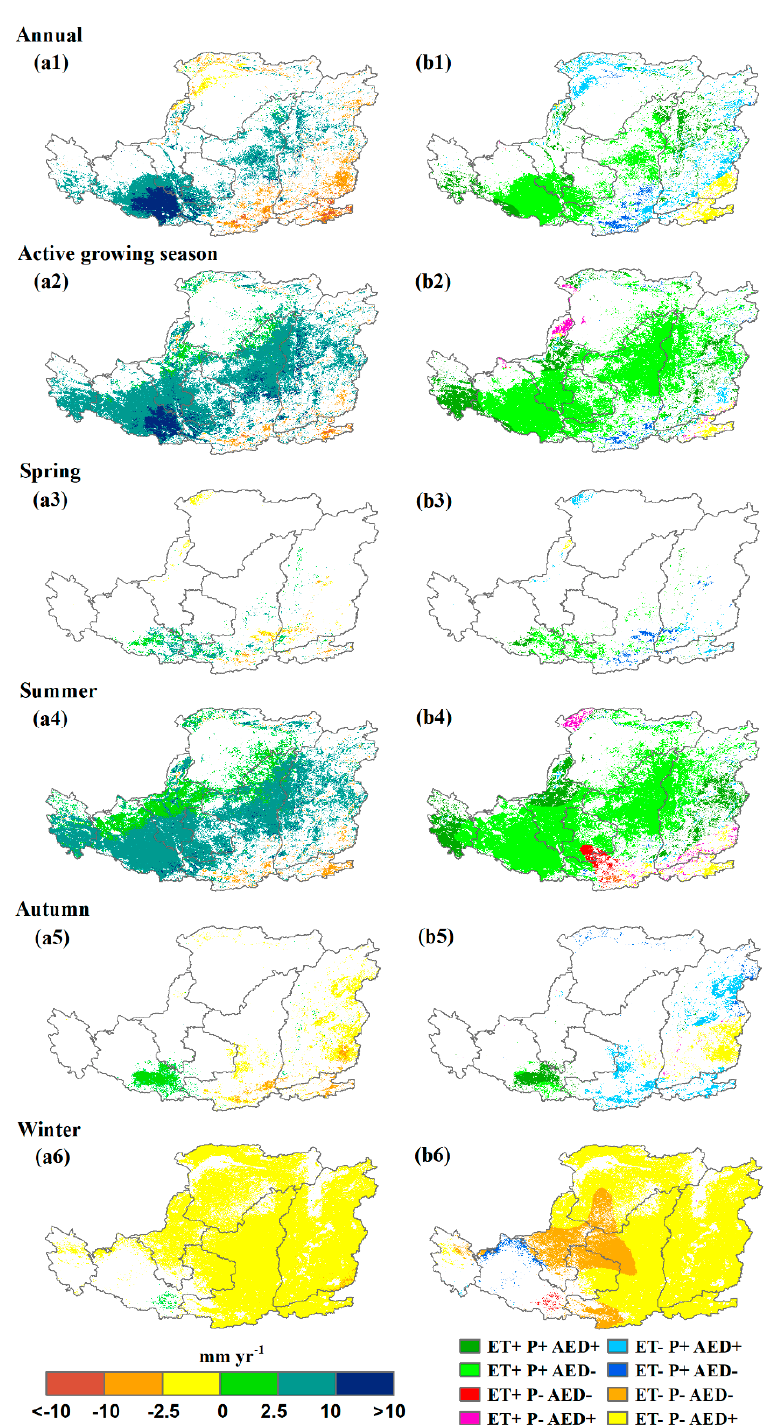
Figure 4. Spatial distributions of ( a ) ET trends and ( b ) synthetic variation signs of ET, P, and AED at the timescales of (1) annual, (2) active growing season, (3) spring, (4) summer, (5) autumn, and (6) winter during the time period from 2000 to 2014. Symbols “+” and “–“ in the right legend indicate increasing and decreasing trends, respectively. This figure only shows pixels with significant ET trends ( p -value < 0.05).